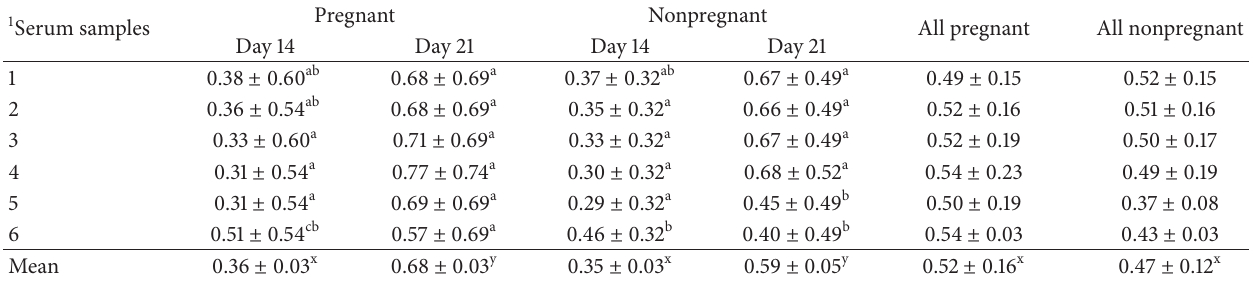
Table 3: LSMeans and standard errors for concentrations of PGFM (ng/mL) for d 14 and 21 in nonpregnant and pregnant